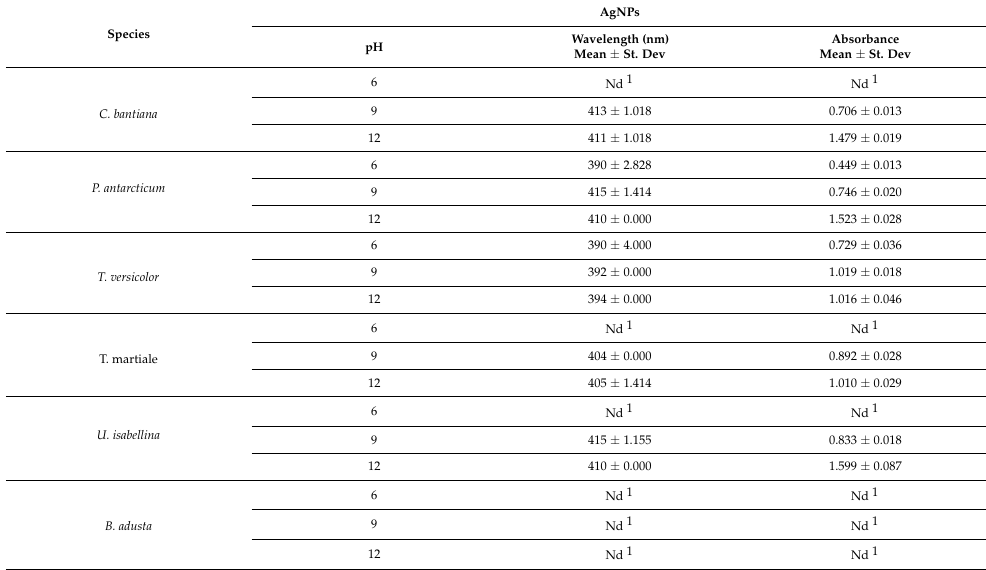
Table 2. UV-Vis spectrophotometric statistical analysis of the wavelength associated with a maximum absorbance of the AgNPs synthesised using FCF extract, 0.5 mM AgNO 3 , 1 h reaction time, 90 ◦ C and different pH values (6, 9 and 12). AgNPs Species pH Wavelength(nm) Mean ± St. Dev Absorbance Mean ± St.